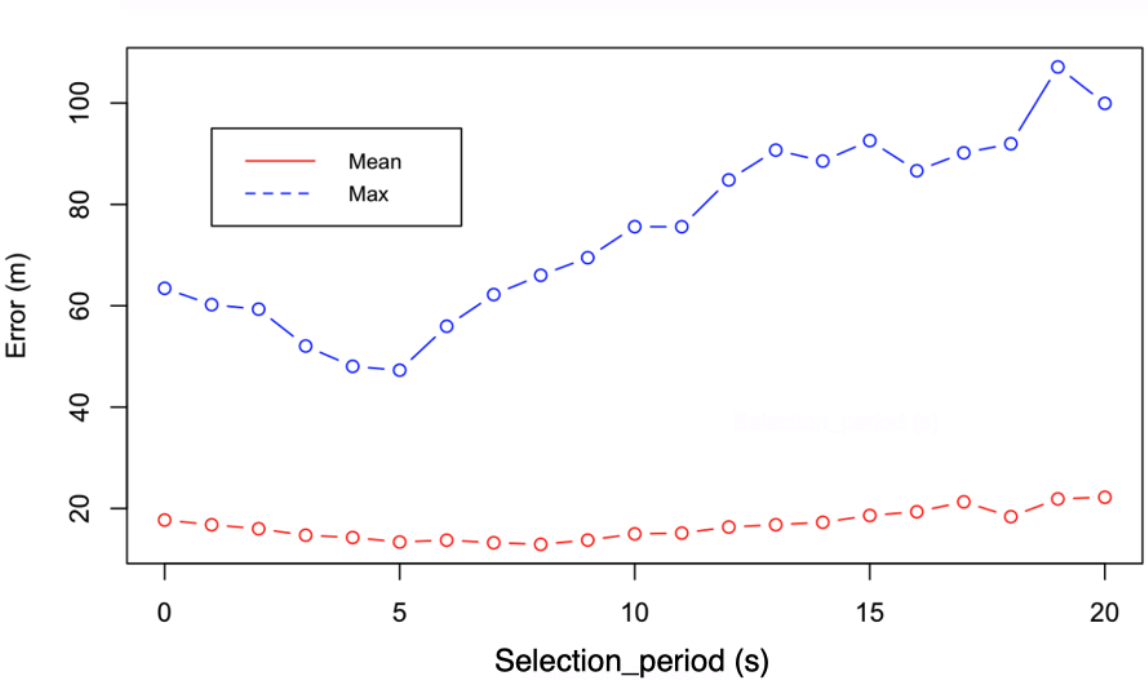
Figure 4. Maximum and mean error of the distance estimation versus the sampling period of the localization signal selection_period computed on all available tests. The 5 seconds value minimizes both mean and maximum